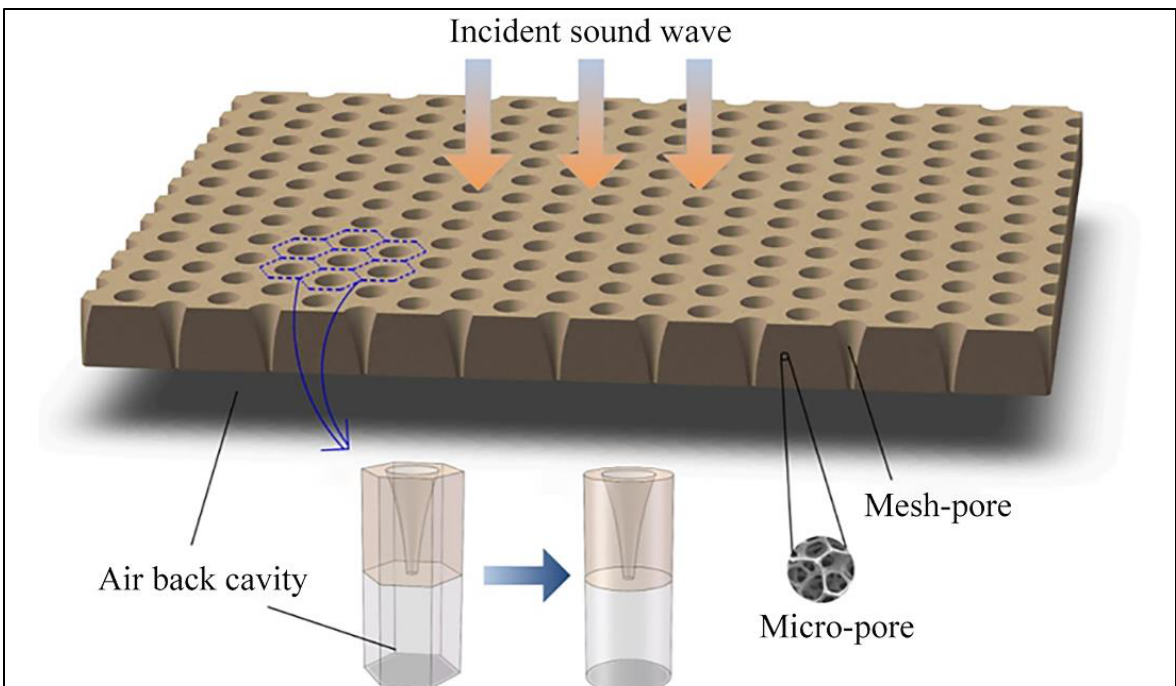
Figure 7. Schematic illustration of a gradually perforated porous material backed with a Helmholtz resonator. Reprinted with permission from ref. [93]. Copyright 2021 Elsevier.